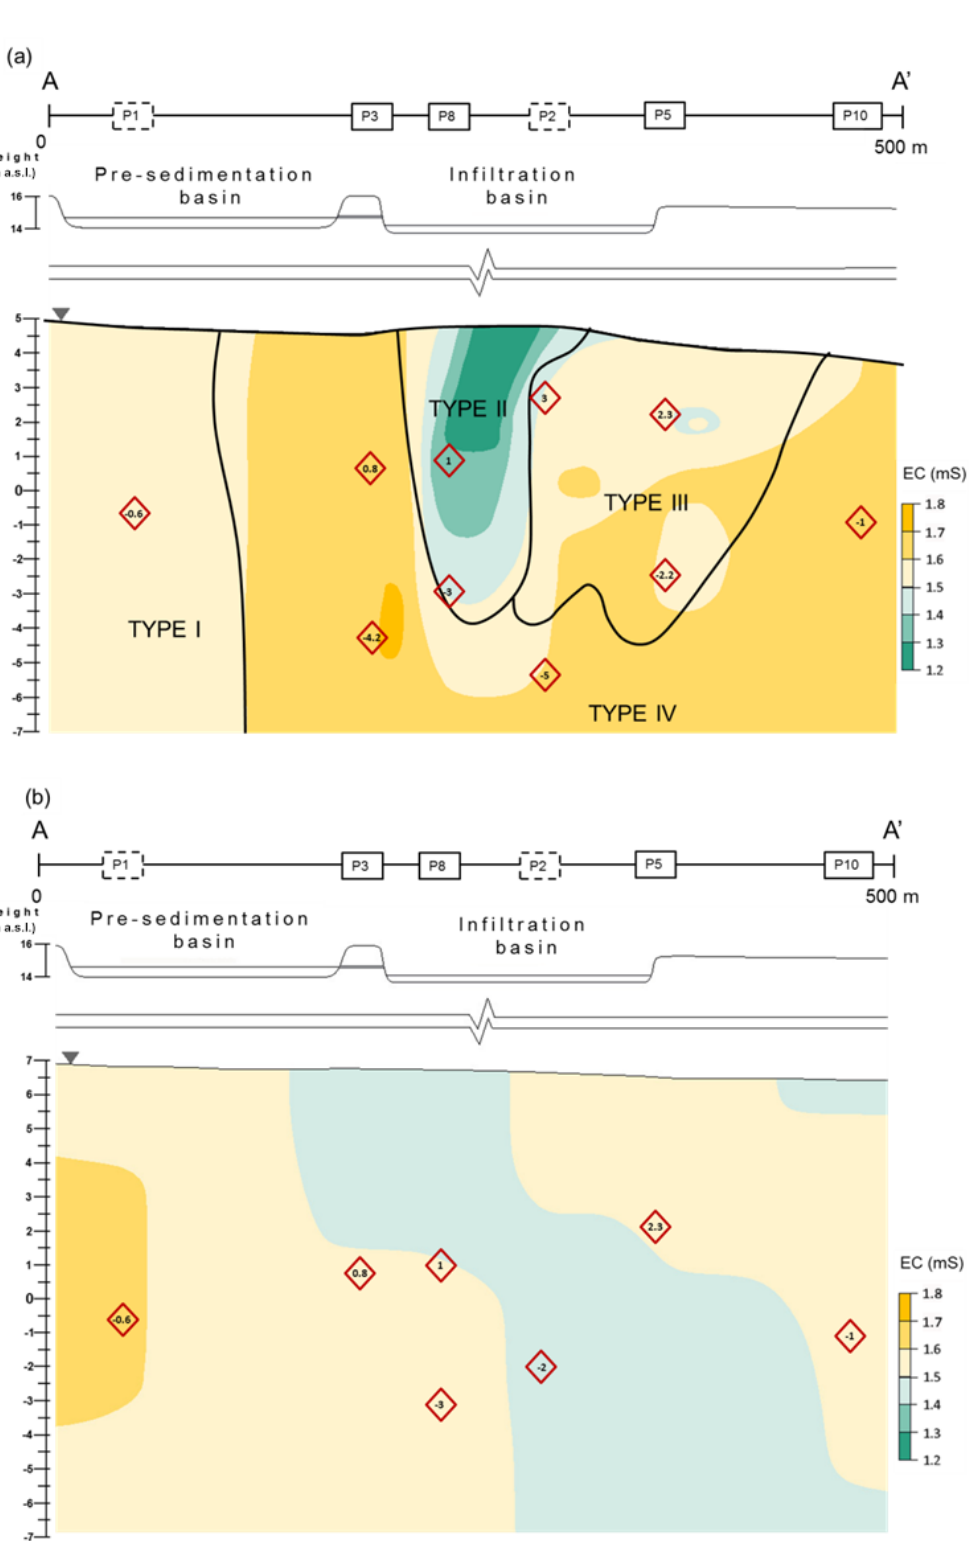
Figure 3. Electrical-conductivity distribution at the local scale in (a) July 2014 (wet) and (b) March 2015 (dry).